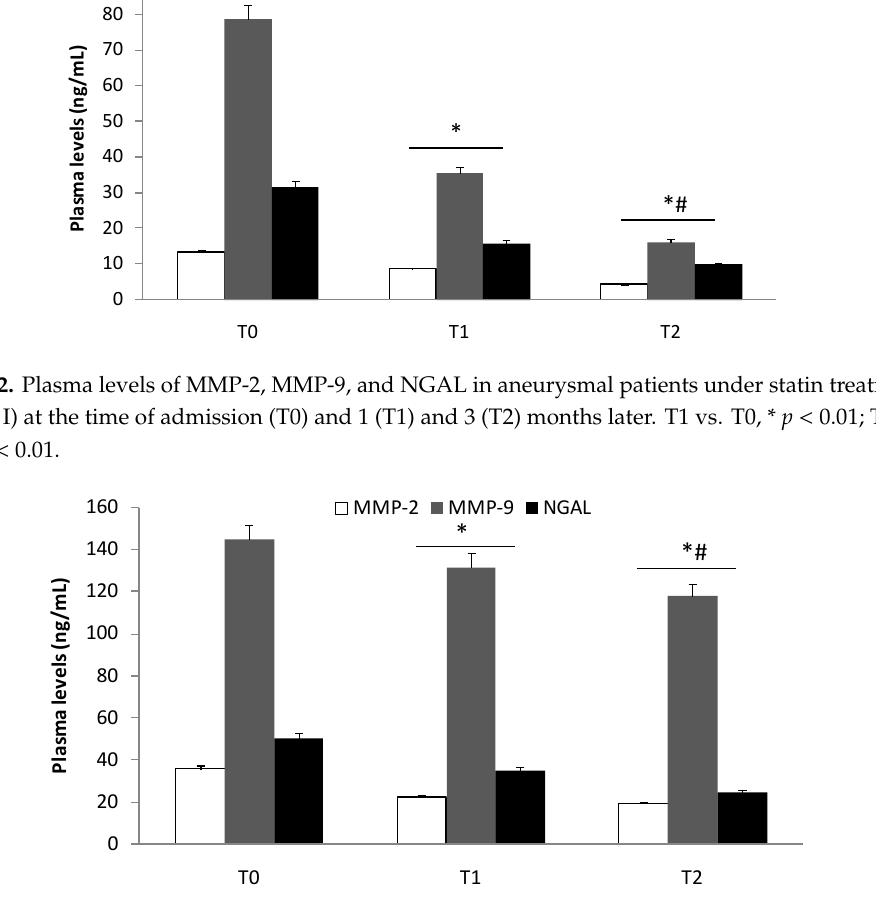
Figure 3. Plasma levels of MMP-2, MMP-9, and NGAL in aneurysmal patients free of statin treatment (Group II) at the time of admission (T0) and 1 (T1) and 3 (T2) months later. T1 vs. T0, * p < 0.05; T2 vs. T1, # p < 0.05.